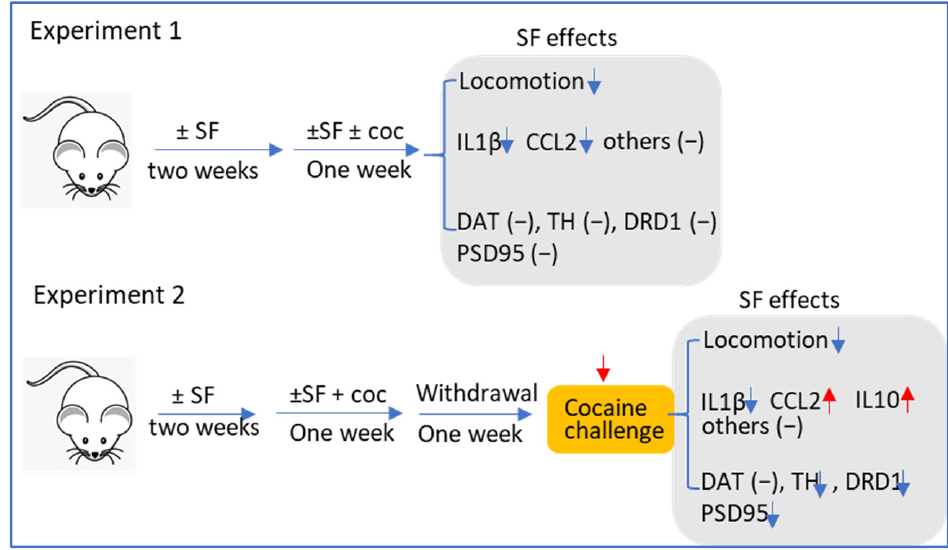
Figure 8. The summarization of the effects of SF on mice with different cocaine regimens. It is possible that the upregulation of dopamine signaling in experiment 2 (cocaine withdrawal mice with cocaine challenge) might also be due to cocaine withdrawal